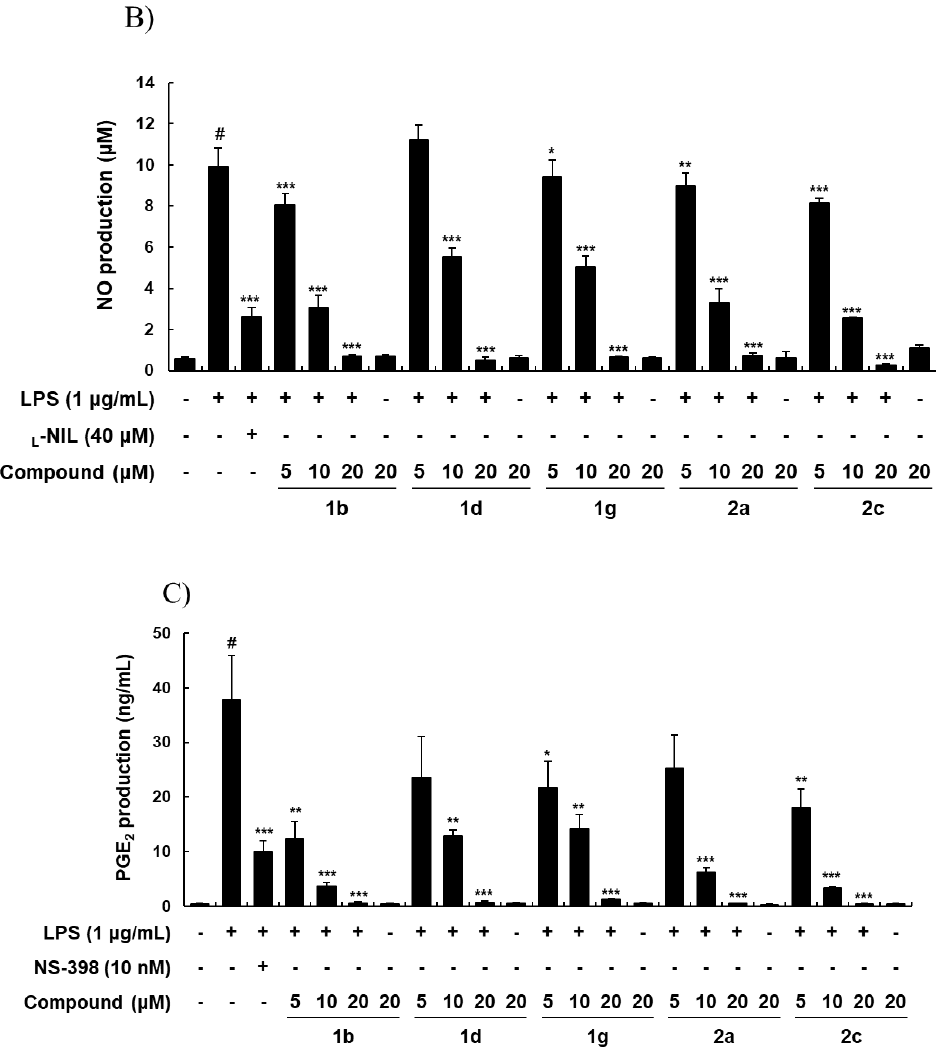
Figure 2. ( A ) In vitro cytotoxicity, ( B ) nitric oxide inhibition, and ( C ) prostaglandin E 2 inhibition of compounds 1b , 1d , 1g , 2a , and 2c . Data are presented as the means ± SD of three independent experiments. # p < 0.05 versus the control cells; *** p < 0.001 versus lipopolysaccharide-stimulated cells; ** p < 0.05 versus lipopolysaccharide-stimulated cells; * statistical significances were compared using ANOVA and Dunnett’s post hoc test.